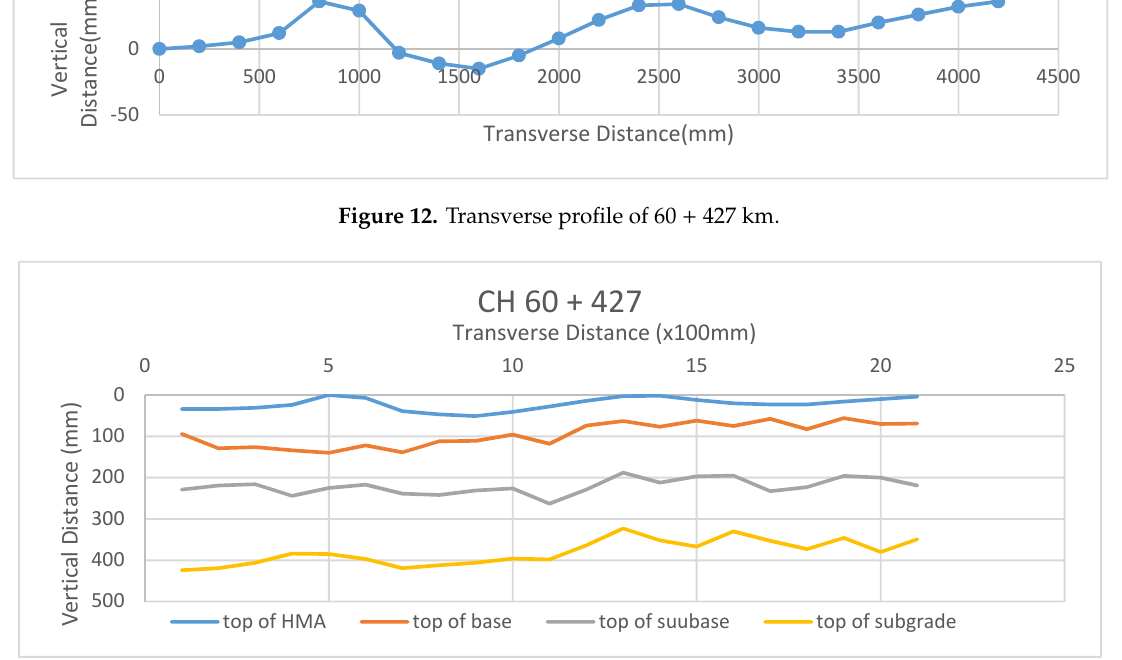
Figure 13. Profile of trench measurements of 60 + 427 km.